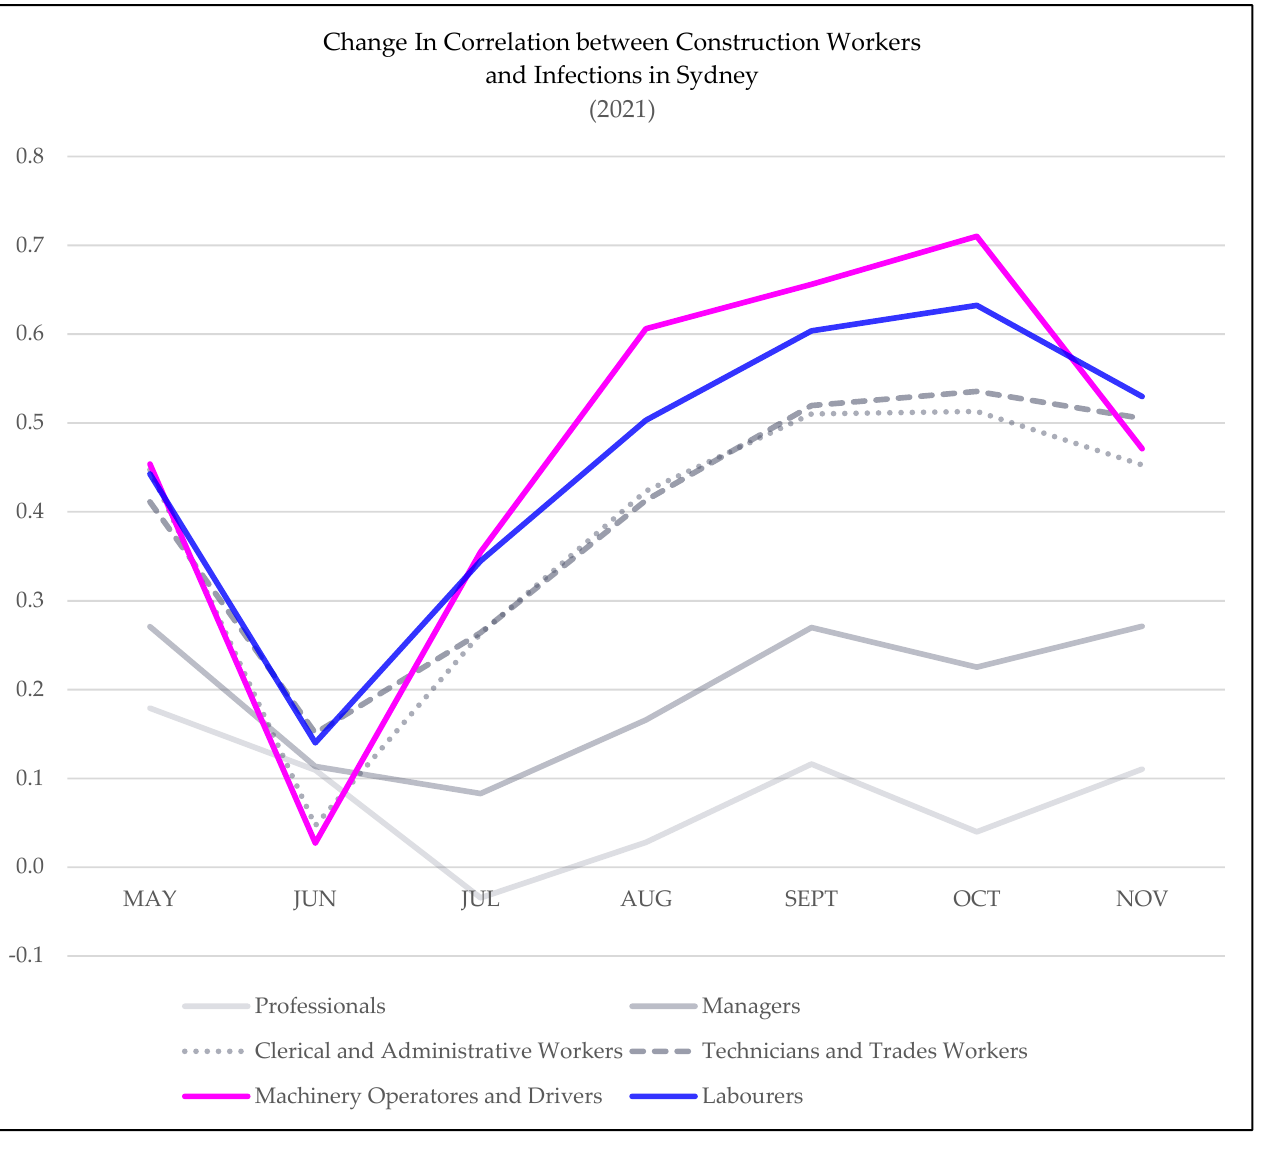
Figure 6. The changing risk profile of construction workers over the duration of the outbreak of the Delta Variant in Sydney.